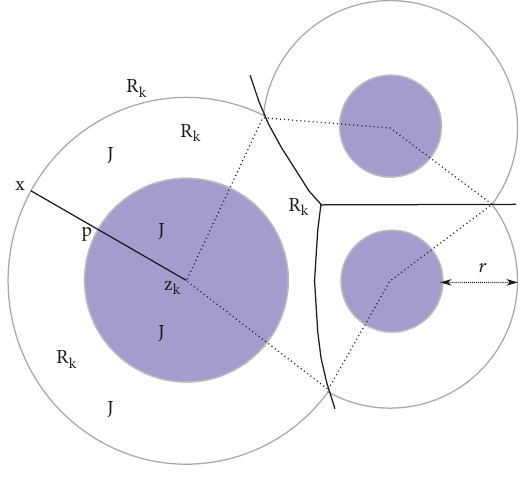
Figure 2: Voronoi cells,